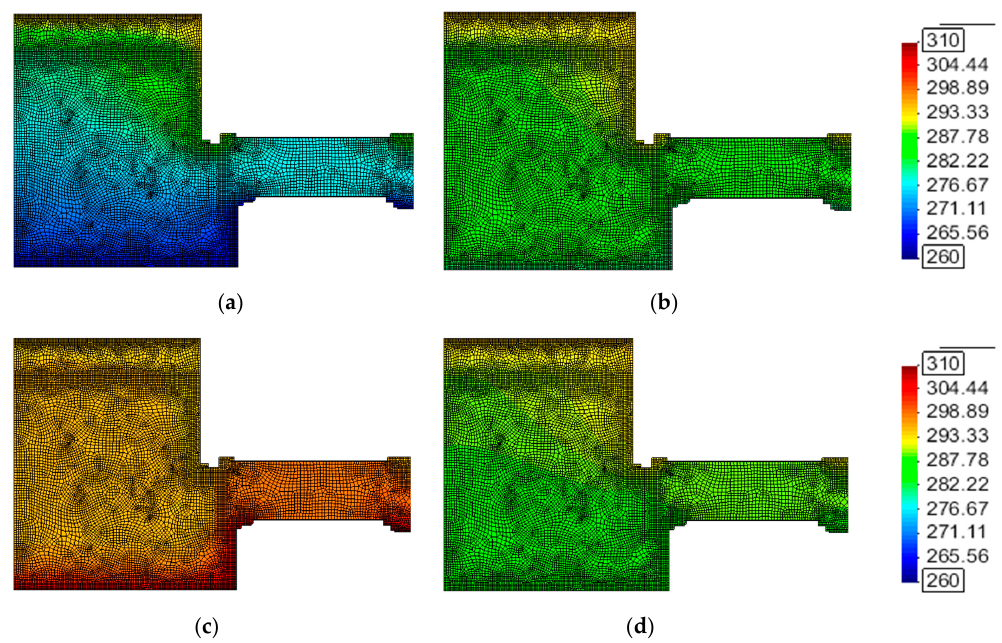
Figure 11. Temperature distribution (K) over the window jamb provided with the interior thermal insulation made of mineral wool: ( a ) 9 January, 16:00, ( b ) 10 April, 22:00, ( c ) 11 July, 11:00, and ( d ) 10 October, 10:00. The temperature values were obtained using computational modeling technique described in Section 4.